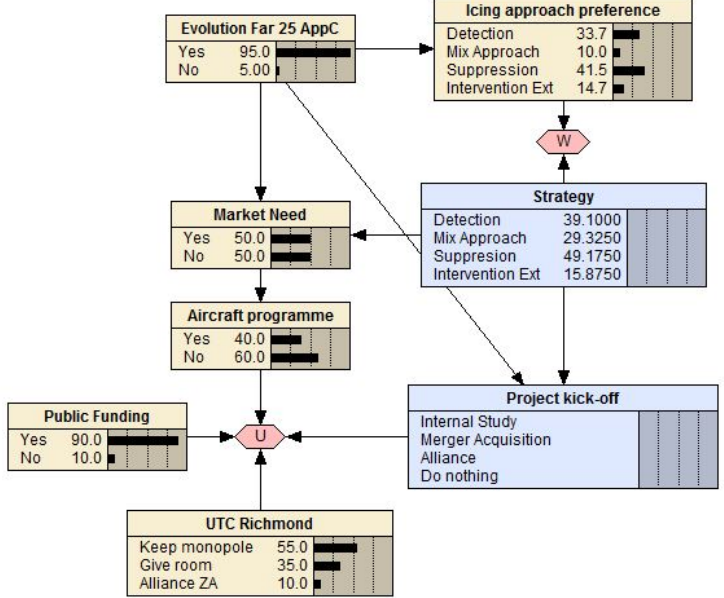
Fig. 2. First decisional setting: Beginning the exploration and challenging rational decision